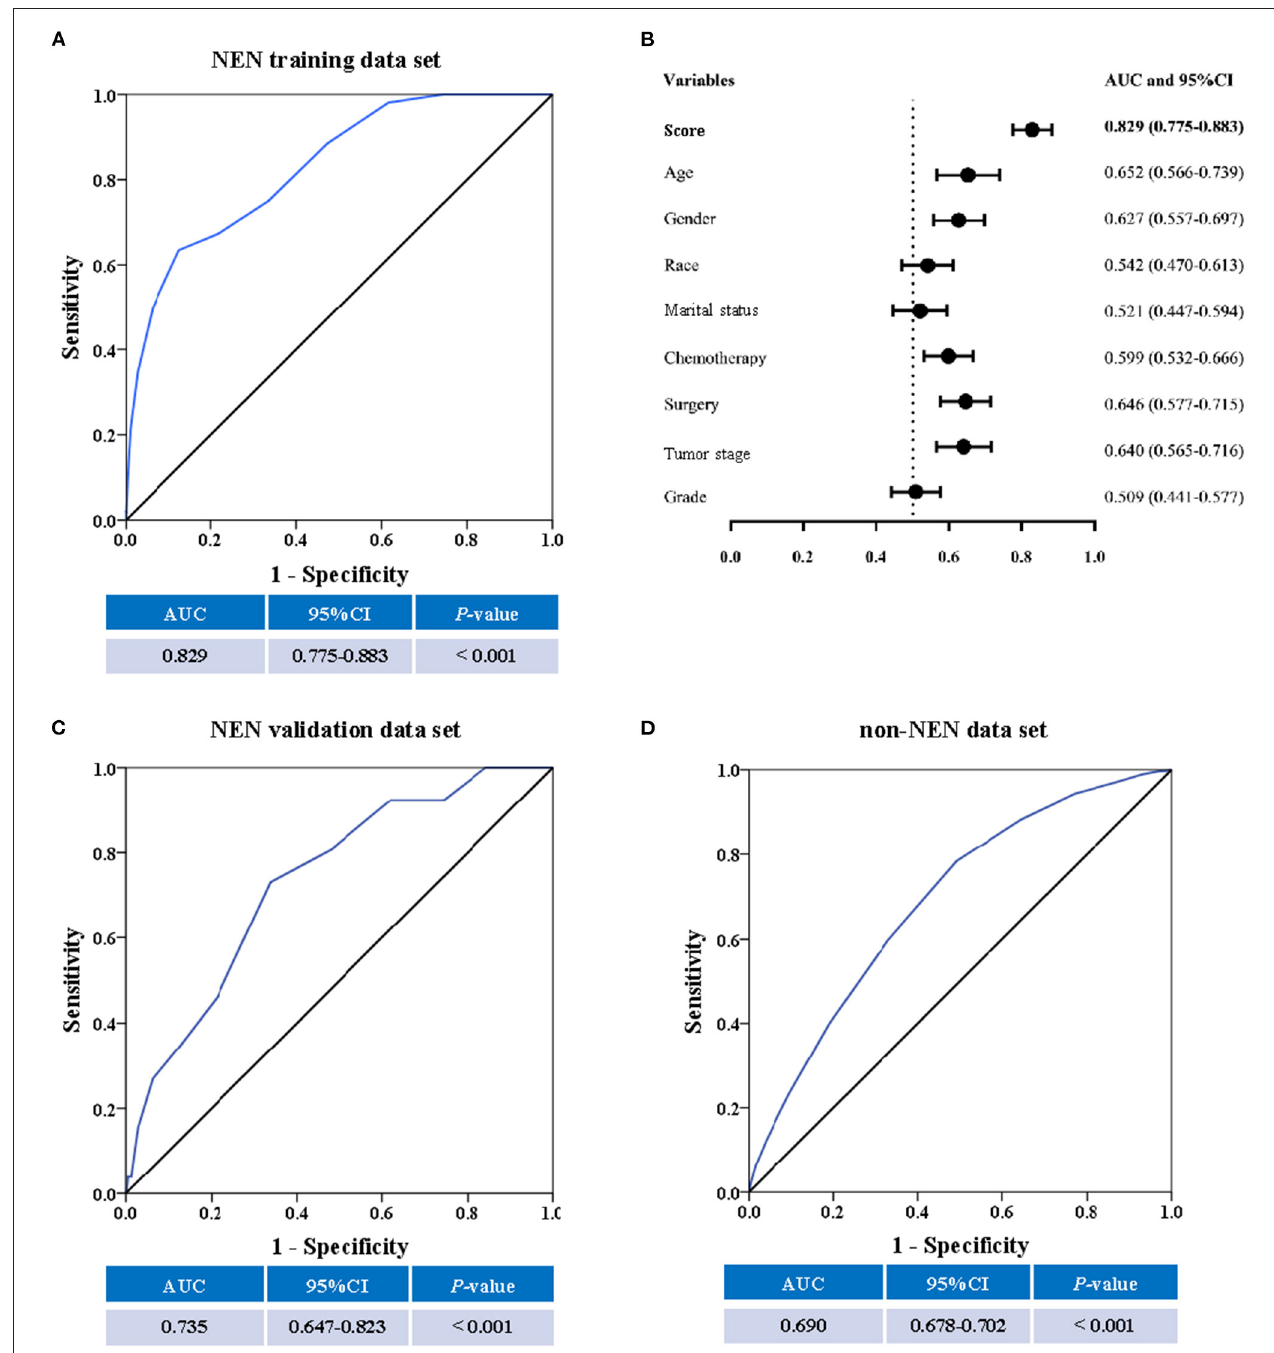
FIGURE 4 | The predictive ability of the score. The receiver operating characteristic (ROC) curve, the area under the curve (AUC) and the confidence interval (CI) suggest a significant discriminatory power of the score when distinguishing between suicide patients from non-suicide patients (A) . In addition, the discriminatory power of the score is significantly superior to single factors such as age, gender, race, marital status, chemotherapy, surgical procedure, cancer stage, and cancer grade (B) . Moreover, the SEER score could distinguish suicide from non-suicide patients in the validation cohort (C), and the non-NEN cohort (D)